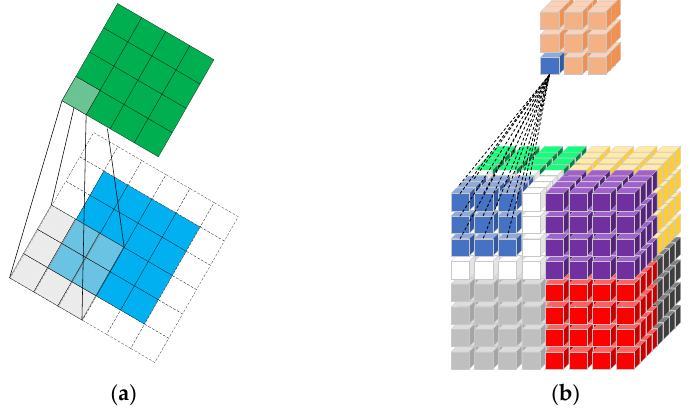
Figure 3. Schematic diagrams of ( a ) 2-D convolution and ( b ) 3-D convolution.